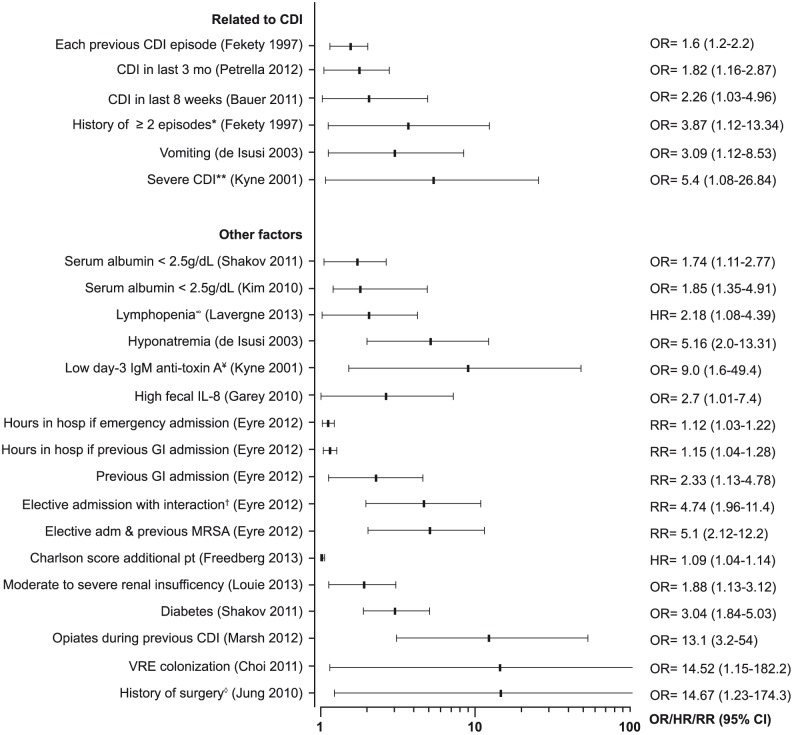
Other risk factors for recurrence of CDI.* History of recurrence vs. new CDI. ** Modified Horn’s index (3 pts). ∞ Lymphopenia at completion of CDI treatment: Absolute cell count <1.0×109/L. ¥<2.22 ELISA units, adjusted on disease severity. † Elective admission vs. emergency if previous dialysis/chemotherapy (interaction). ◊ History of surgery within 1 month before CDI treatment. MRSA = previous methicillin-resistant Staphylococcus aureus (interaction). VRE = vancomycin-resistant enterococci.